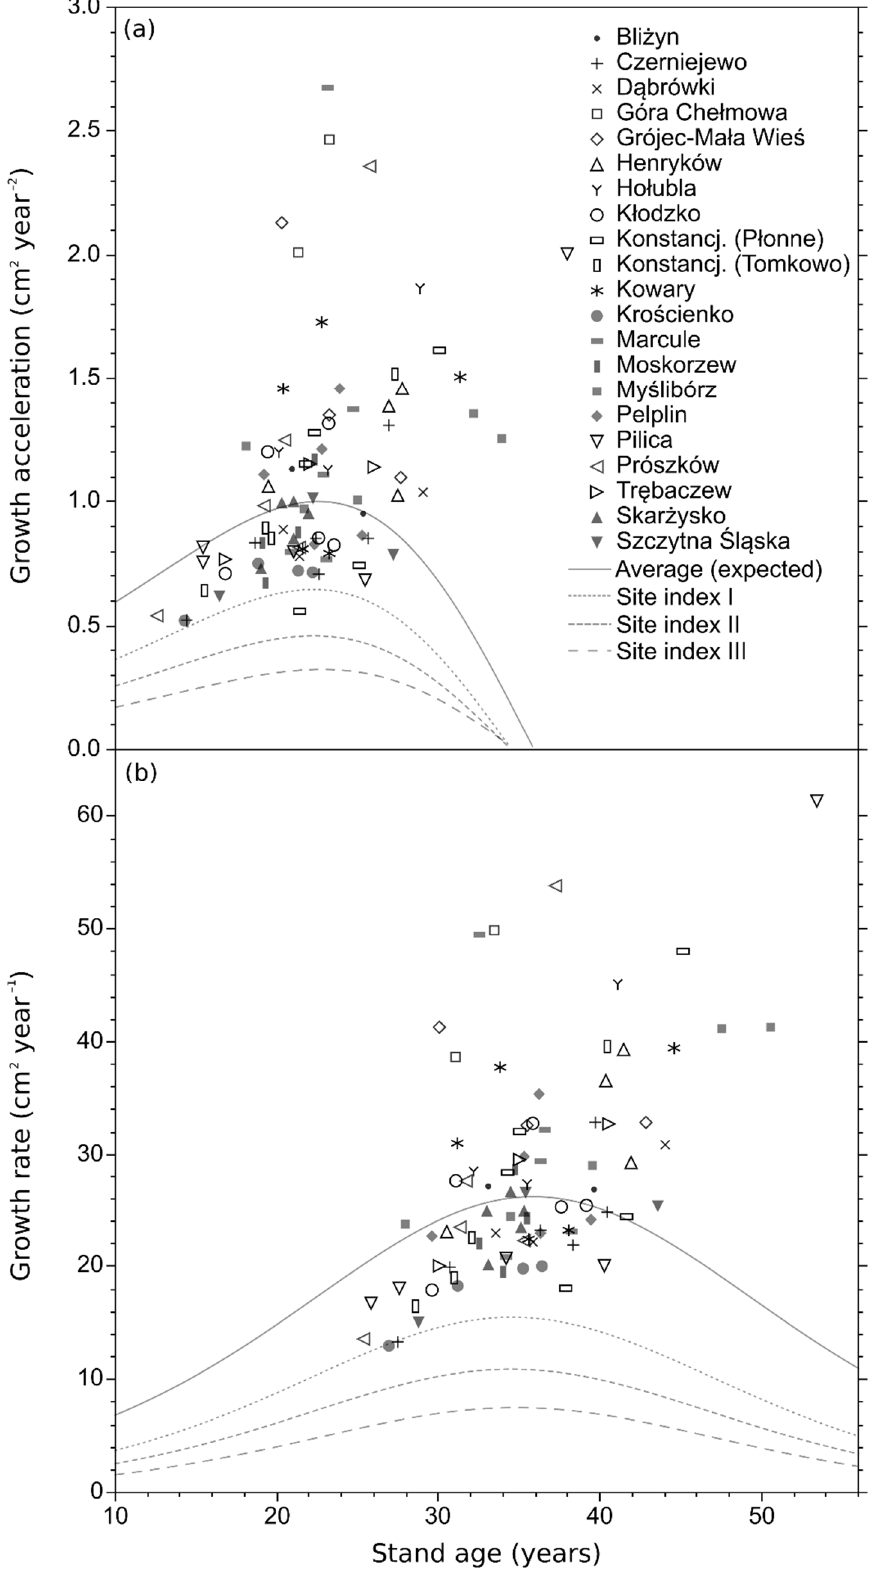
Figure 2. The values of the maximal acceleration ( a ) and growth rate ( b ) of the average basal area for all the experimental plots ( n = 86) for the provenances in the experimental trial. The solid lines indicate the expected curve for all provenances. The dashed lines indicate the curves for the deterministic Schober model for three site indexes [12,21]. The details of all markers are shown in the key.